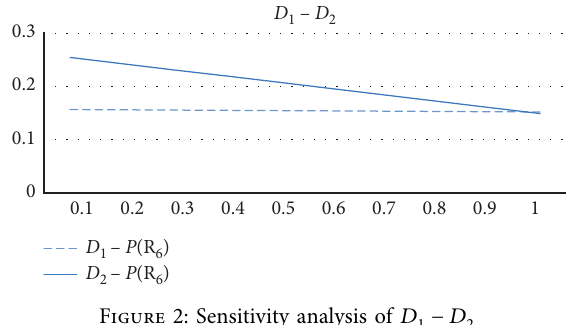
Figure 2: Sensitivity analysis of D